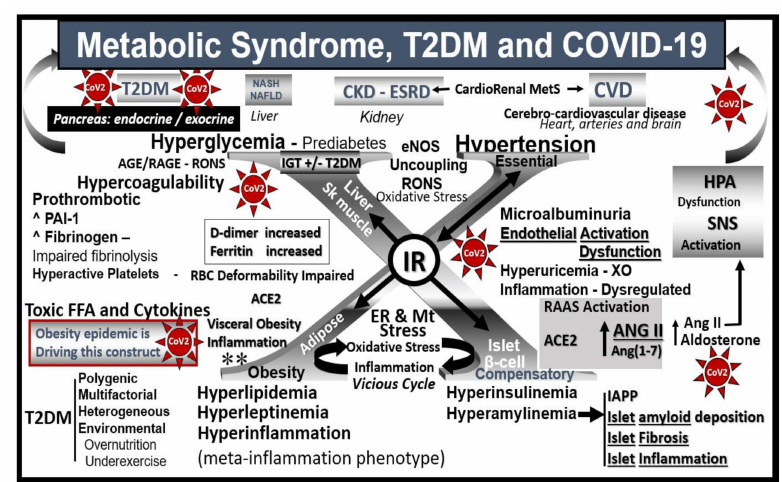
Figure 1. Metabolic syndrome, T2DM and COVID-19 are multisystem diseases. This image illustrates how metabolic syndrome (MetS) / type 2 diabetes mellitus (T2DM) and coronavirus disease